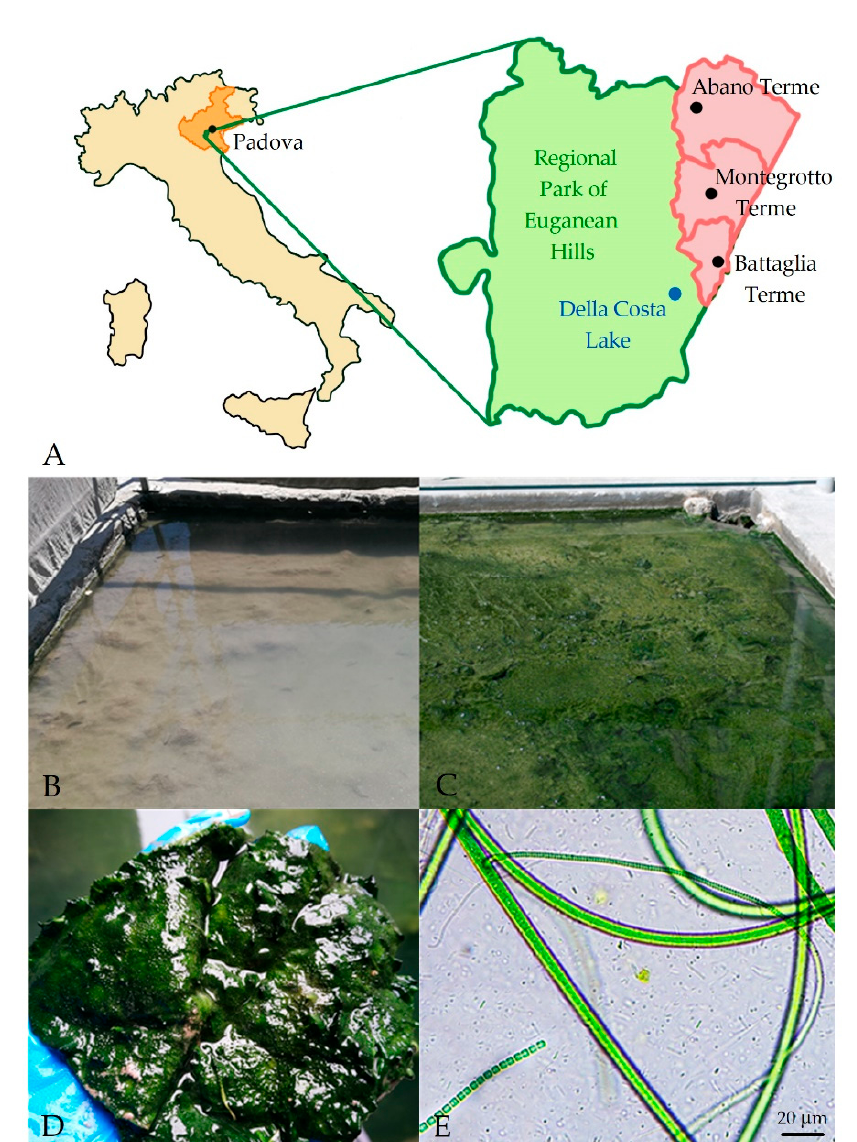
Figure 1. ( A ) Localization of the Euganean thermal district. Green represents the area of the Regional Park of the Euganean Hills, while the municipalities in which sampled sites are located are in red. ( B , C ) Example of a maturation pond at the beginning and at the end of mud maturation process. During maturation the virgin clay (B) is progressively colonized by a microbiota leading to the appearance on the mud surface of a biofilm with a typical green pigmentation ( C ) due to the presence of Cyanobacteria. ( D ) Portion of microbial biofilm collected from the mature mud surface and ( E ) image at light microscope of the microbial species colonizing it.